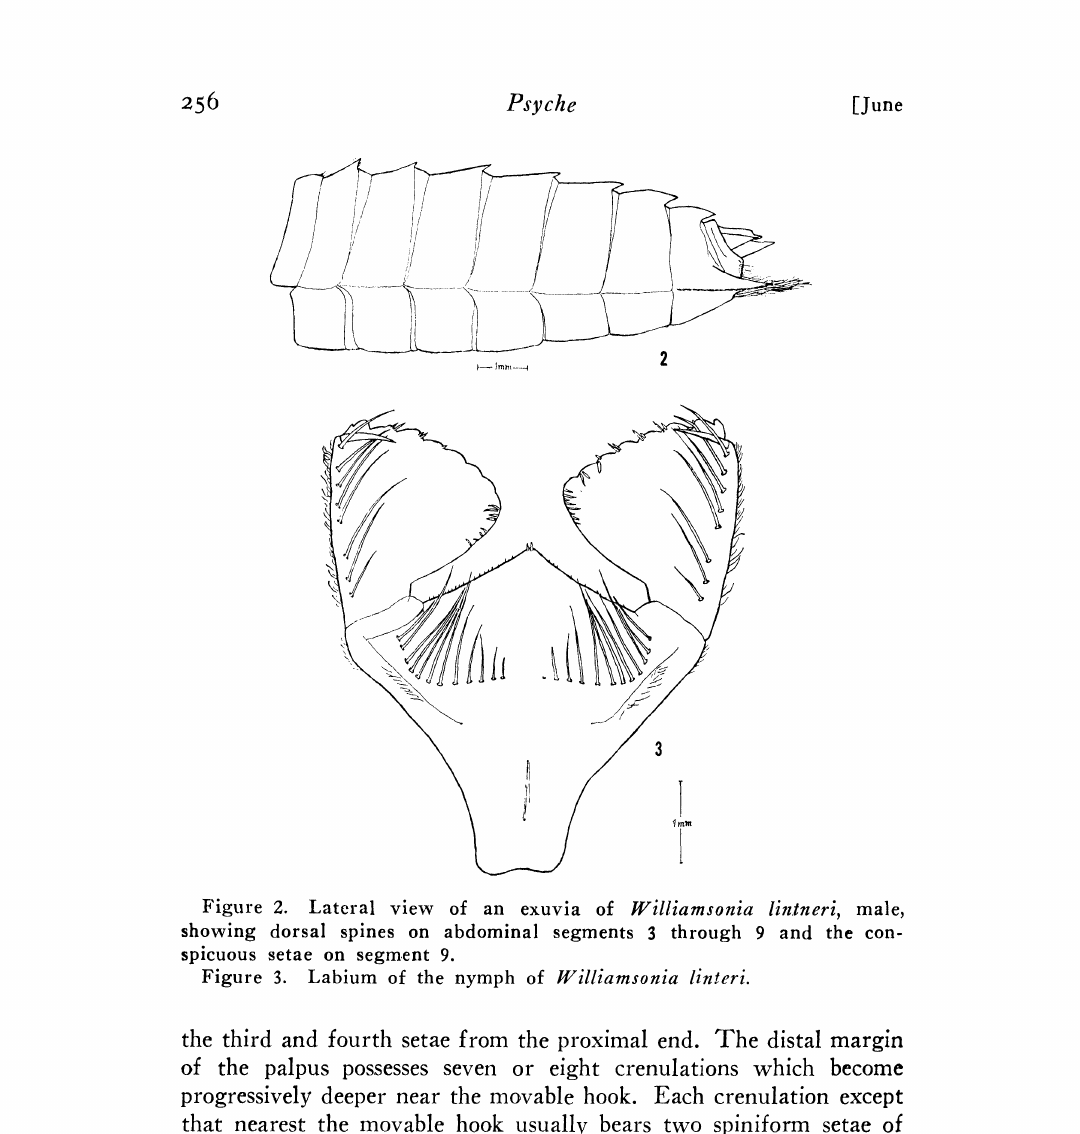
Figure 2. Lateral view of an exuvia of tVilliamsonia lin.tneri, male, showing dorsal spines on abdominal segments through 9 and the con- spicuous setae on segment 9. Figure 3. Labium of the nymph of Williamsonia linteri.